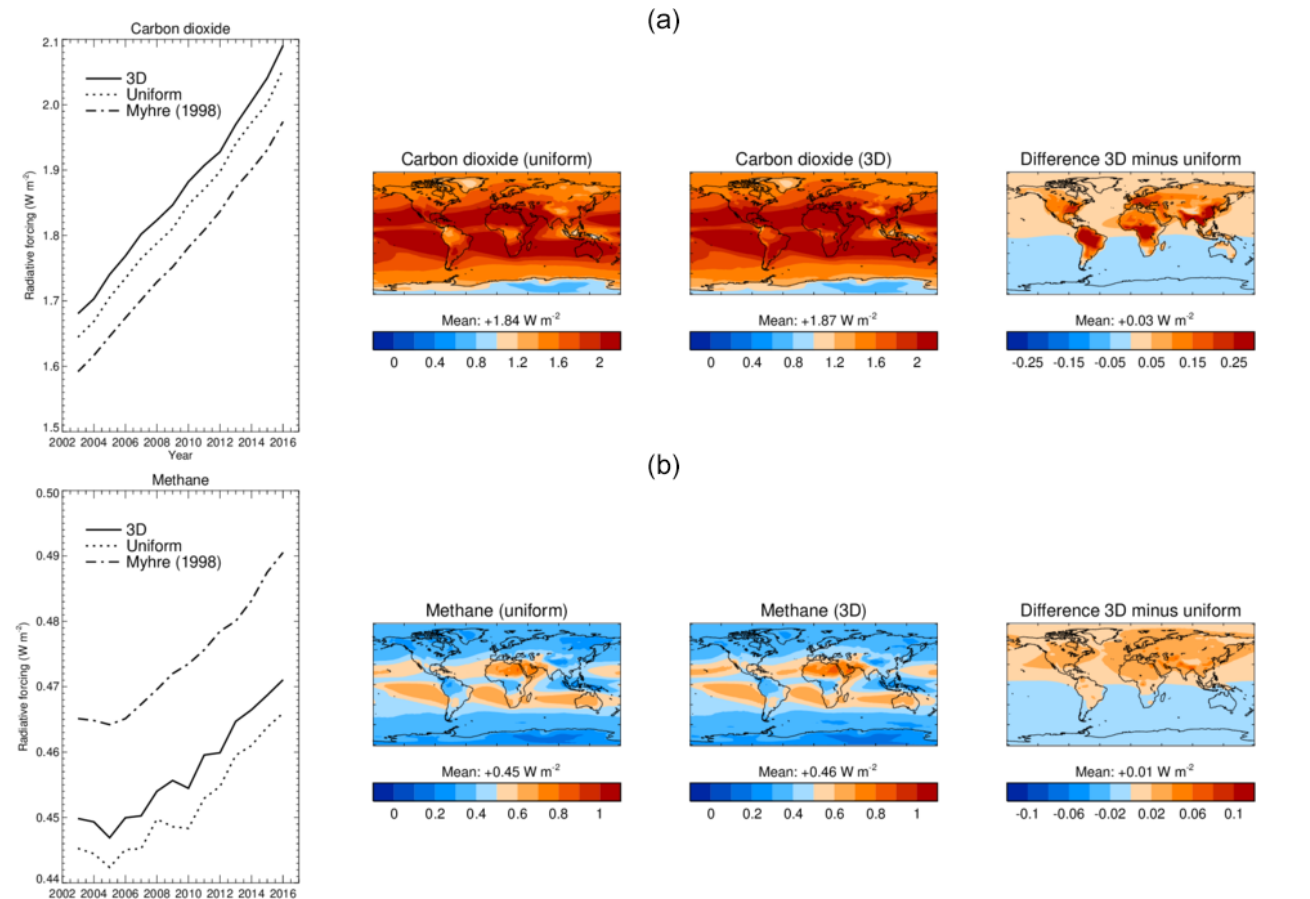
Figure 13. Comparison of stratospherically adjusted radiative forcing (in Wm − 2 ) of carbon dioxide (a) and methane (b) based on either the three-dimensional distributions produced by CAMS Greenhouse Gas Flux or the surface measurements of the NOAA Earth System Research Laboratory for carbon dioxide and the Advanced Global Atmospheric Gases Experiment for methane. Corresponding concentration time series are shown in Fig. 2. Panels on the left show time series for 2003–2016, with radiative forcing from three-dimensional distributions shown as a solid line, from uniform concentrations as a dashed line, and from the simplified expressions of Myhre et al. (1998) as a dotted– dashed line. Maps show, from left to right, the distributions from three-dimensional distributions, from uniform concentrations, and their